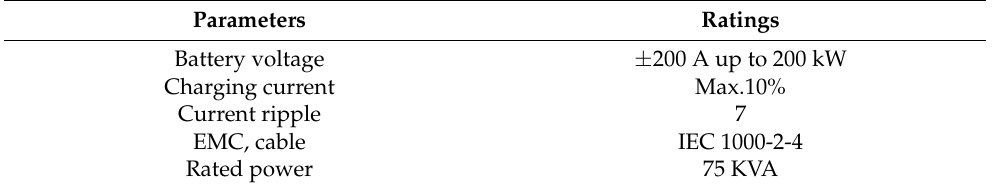
Table 2. Battery charger